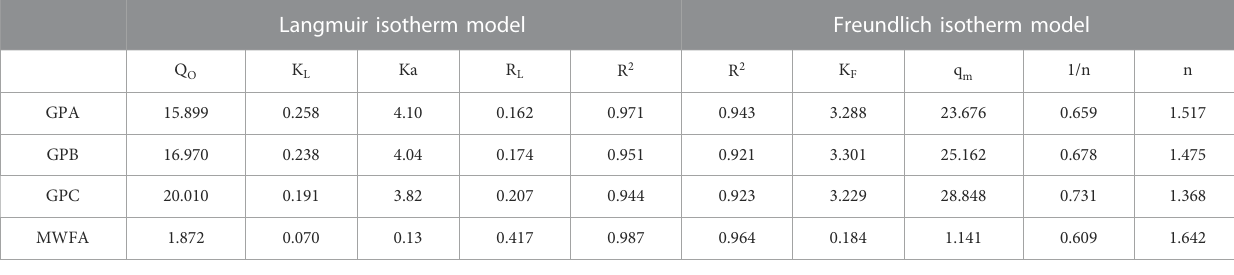
TABLE 4 Langmuir and Freundlich isotherm model data.